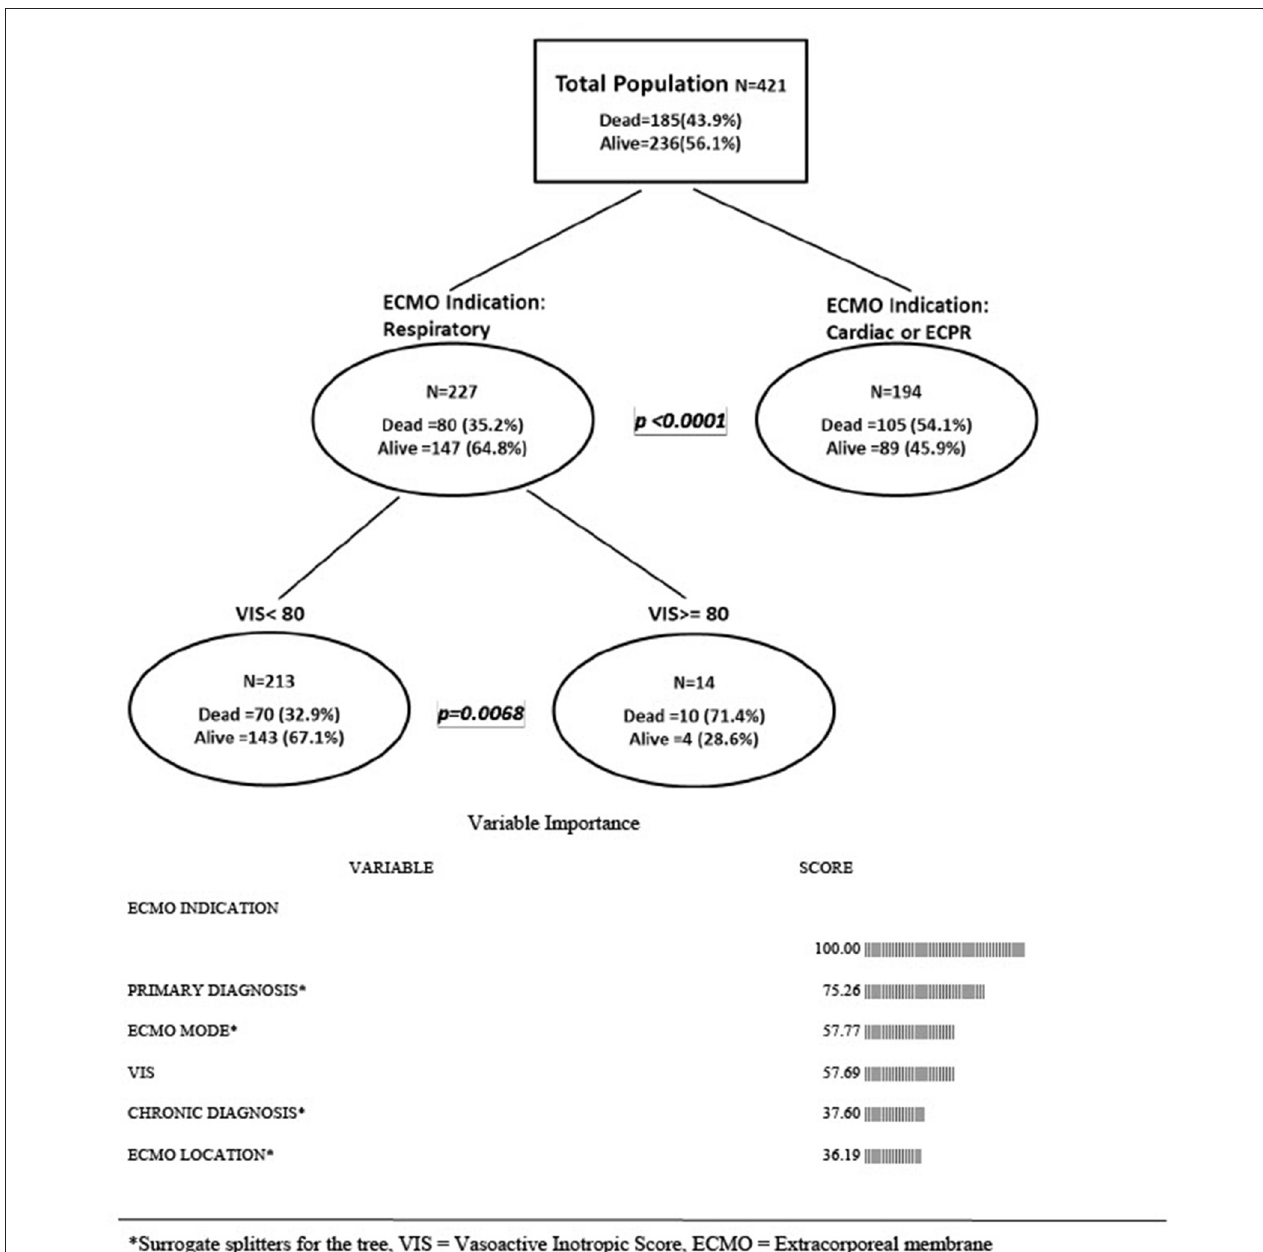
FIGURE 1 | Multivariable classification tree analysis-association of vasoactive inotrope score and other risk factor with mortality. *Surrogate splitters for the tree, VIS, vasoactive inotropic score; ECMO, extracorporeal membrane oxygenation; ECPR, extracorporeal cardiopulmonary resuscitation.